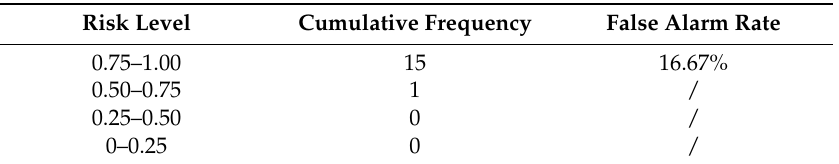
Table 4. The cumulative frequency used to account for the number of real tripping events that fall within each risk level, and the false alarm rate used to account for the case where a higher risk of line tripping was predicted but no actual line tripping